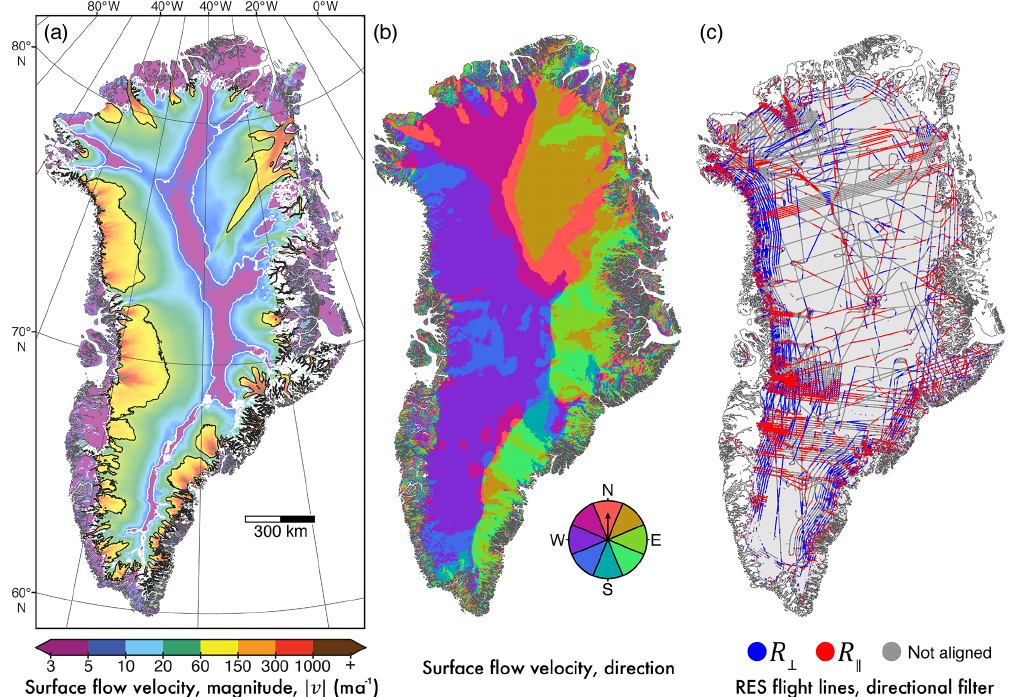
Figure 3. Observed surface ice velocity characteristics of the GrIS used in the filtering of R . (a) InSAR-derived ice surface speed (velocity magnitude; ma − 1 ; Joughin et al., 2016); regions of fast ( | v | > 50ma − 1 ) and slow ( | v | < 5ma − 1 ) flow are demarcated by the black and white contour lines, respectively. (b) Flow direction of ice surface from (a) ; coloured pinwheel denotes direction of surface ice flow, where north is at the top of the page. (c) Radar sounding surveys as in Fig. 1, filtered for alignment with surface flow direction (b) ; flight tracks are categorised as aligned either parallel ( R (cid:107) ) or perpendicular ( R ⊥ ) to surface flow direction (with a ± 20 ◦ threshold) for the analysis of topographic-roughness